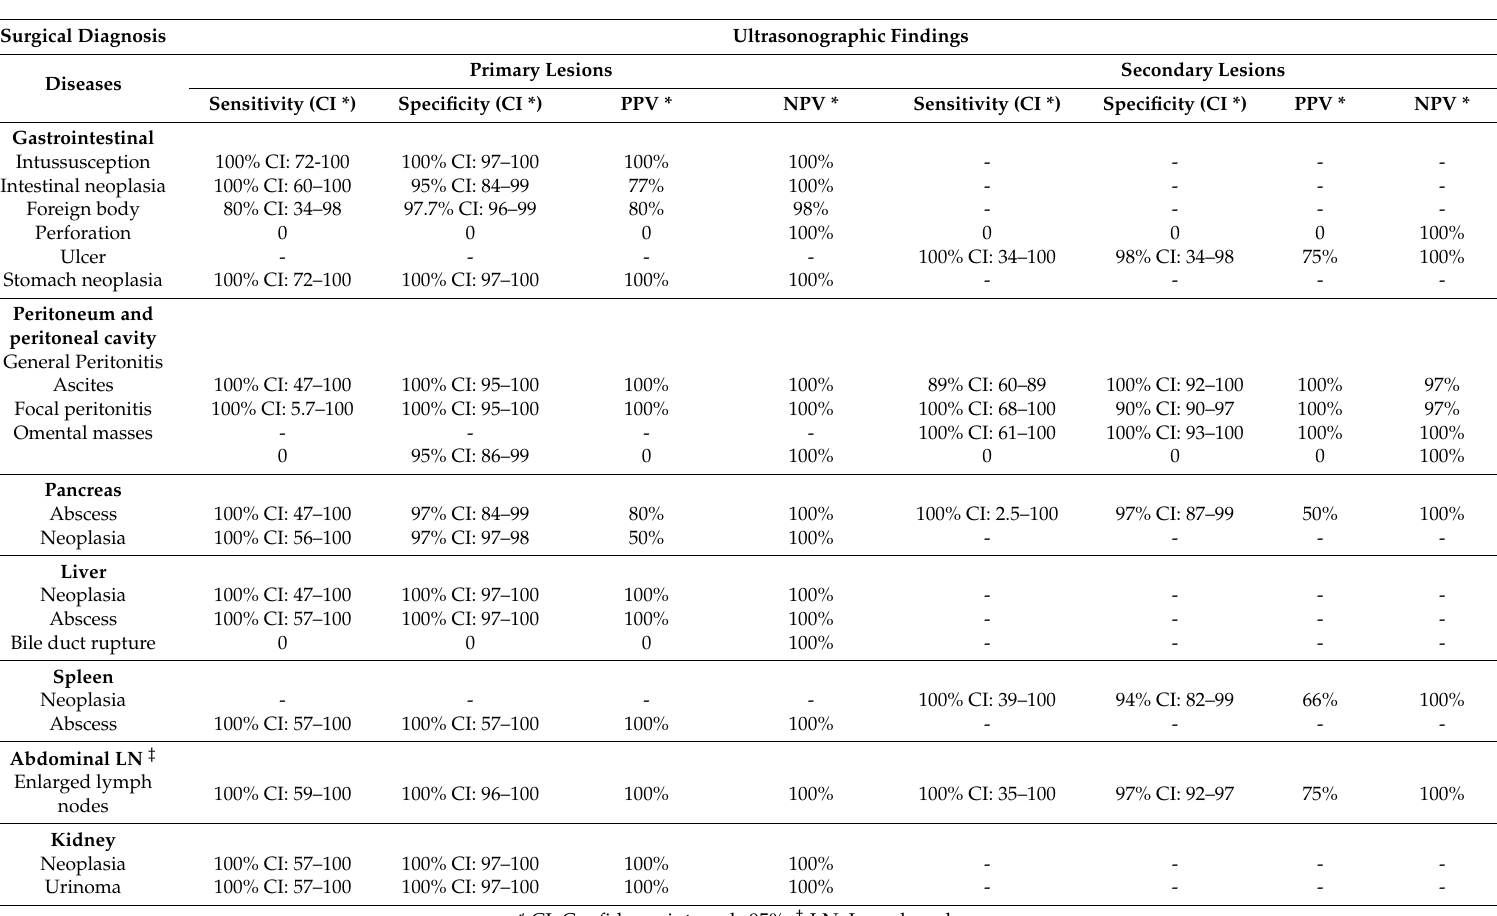
Table 2. Preoperative abdominal ultrasound and intraoperative diagnoses of the primary and secondary lesions based on anatomic location. Sensitivities and specificities (with confidence intervals) of ultrasonography are presented for both primary and secondary lesions identified at surgery. The surgical diagnosis was the “criterion